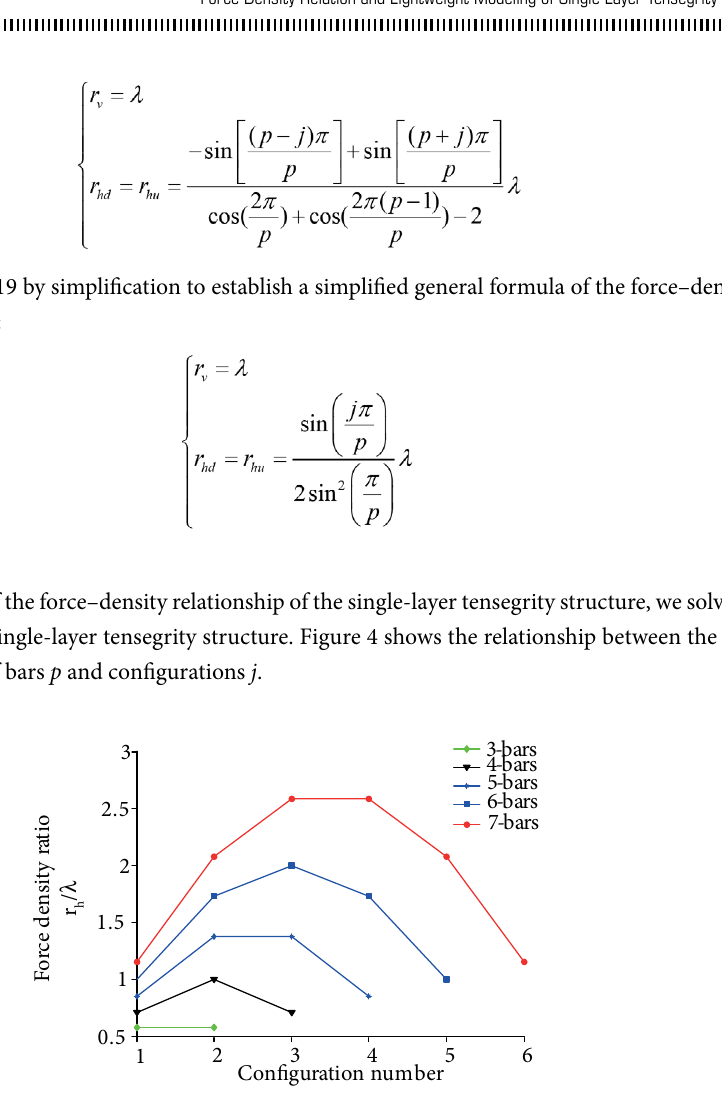
Figure 4. Relationship of force density of common single layer tensegrity